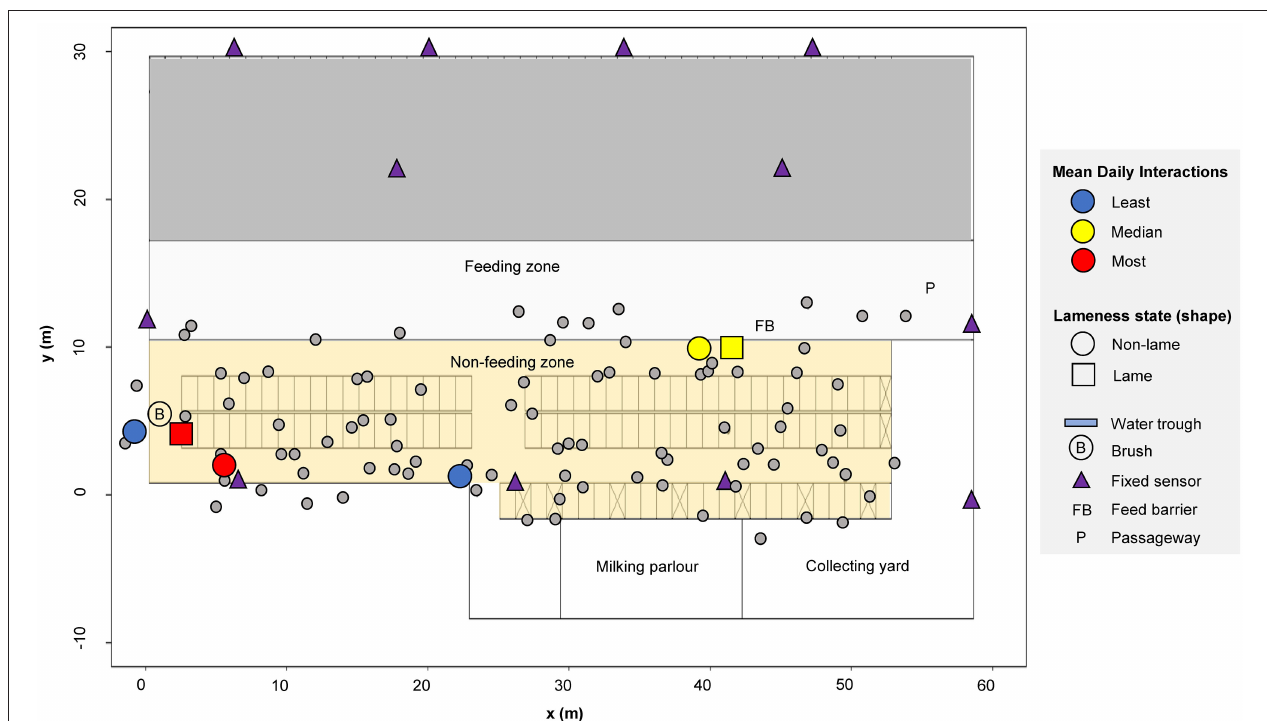
FIGURE 1 | Barn layout showing ( n = 92) example cow locations recorded on 01/10/2020 at 05:09:50. A highlighted illustrative subset of cows ( n = 6) are colored according to their mean daily interactions: least = blue (cow ID = 3124 and 3317), median = yellow (cow ID = 3602 and 3132), most = red (cow ID = 635 and 3361). Data for each individual cow is indicated with a small circle. The area shown in gray (upper barn area) was not used by this group of cows during the study period.